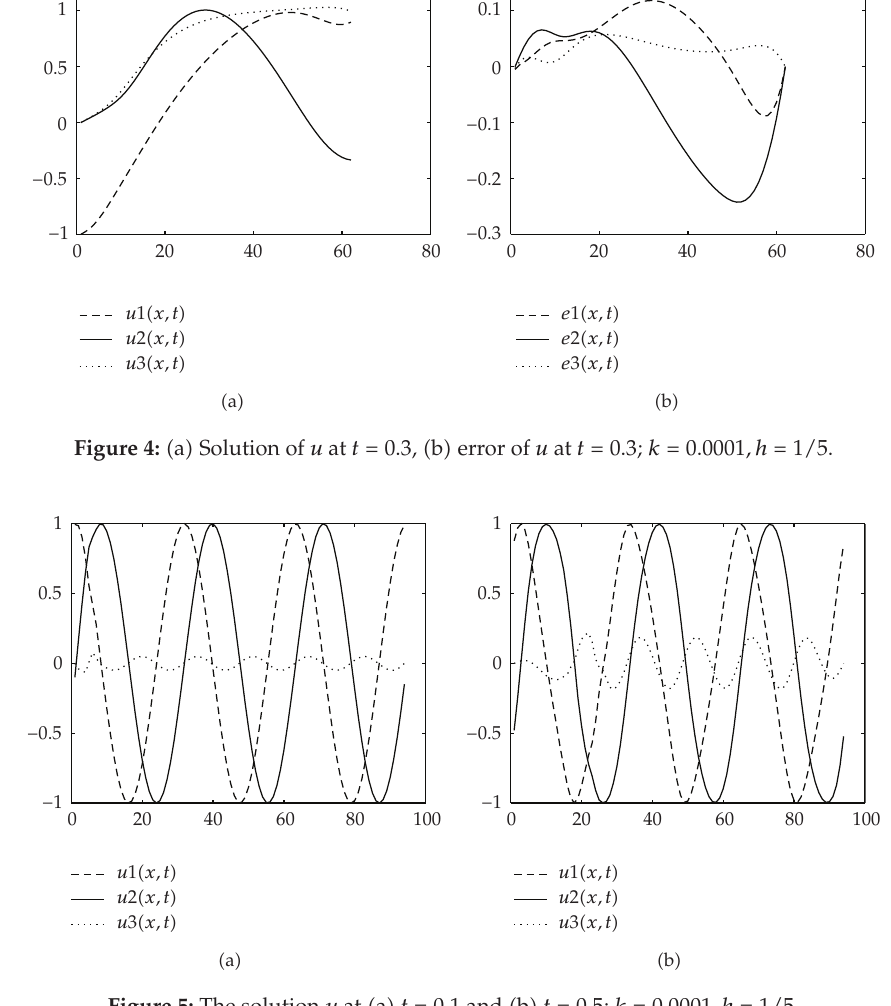
Figure 5: The solution u at (cid:3) a (cid:4) t (cid:7) 0 . 1 and (cid:3) b (cid:4) t (cid:7) 0 . 5; k (cid:7) 0 . 0001 ,h (cid:7) 1 /